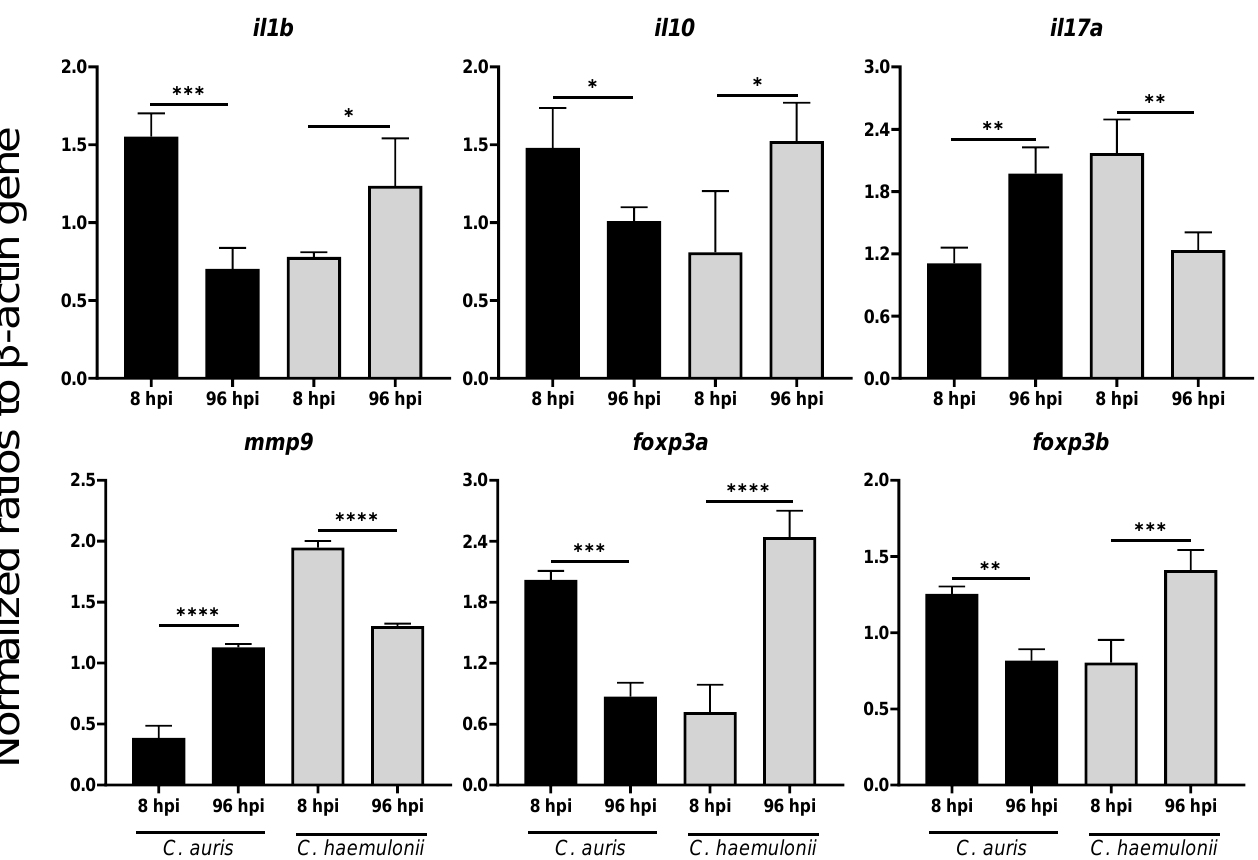
Figure 4. The expression levels of il1b, il10, il17a, mmp9, foxp3a, and foxp3b in zebrafish infected with emerging Candida strains, by timepoint. Each experimental group of 20 zebrafish was injected with 10 7 CFU cells of one of the C. auris strain SI-18-CAU-HEM or the C. haemulonii strain SI-21-CH-PLF. The normalized ratios of expression were calculated by comparison with the level of expression of the β-actin gene in each group at 8 hpi. Each experiment was performed in triplicate. Abbreviations and symbols: hpi, hour-post-infection; *, p < 0.5; **, p < 0.01; ***, p < 0.001; ****, p < 0.0001.